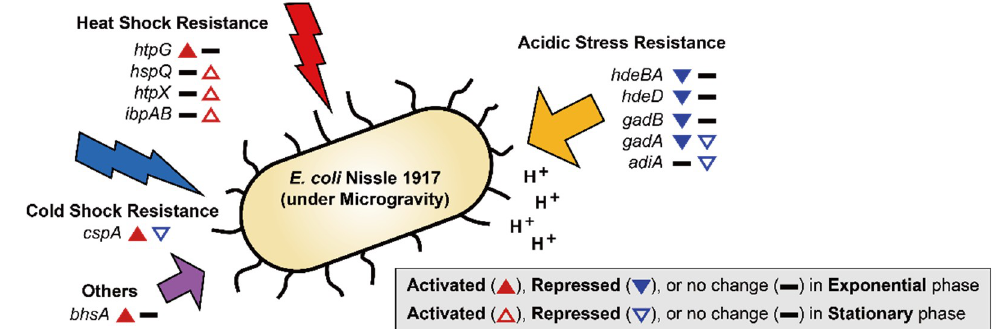
Figure 3. DEGs related to stress resistance are shown. The up-regulated and down-regulated genes under the MG condition compared to the NG condition are depicted by the direction of the up and down arrowheads, respectively. DEGs during the exponential and stationary growth phases are indicated by the solid and empty arrowheads,